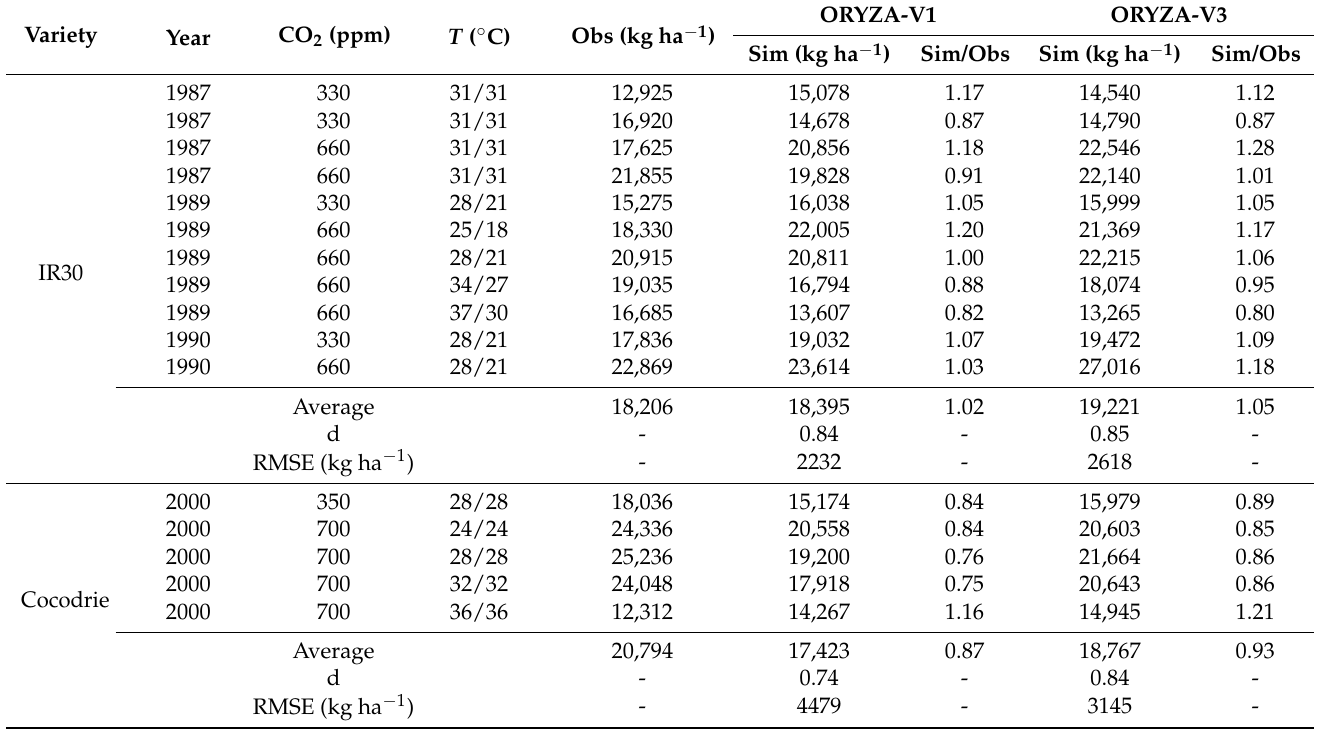
Table 1. Comparison of observed (Obs) and simulated (Sim) above-ground rice biomass for ORYZA- V1 and ORYZA-V3 model versions in response to CO 2 and day/night temperature ( T ) treatments for three rice varieties. The ratio of simulated to observed final biomass (Sim/Obs) was indicated for each individual treatment, and Wilmott’s index of agreement (d) and RMSE computed across all treatments for each variety.